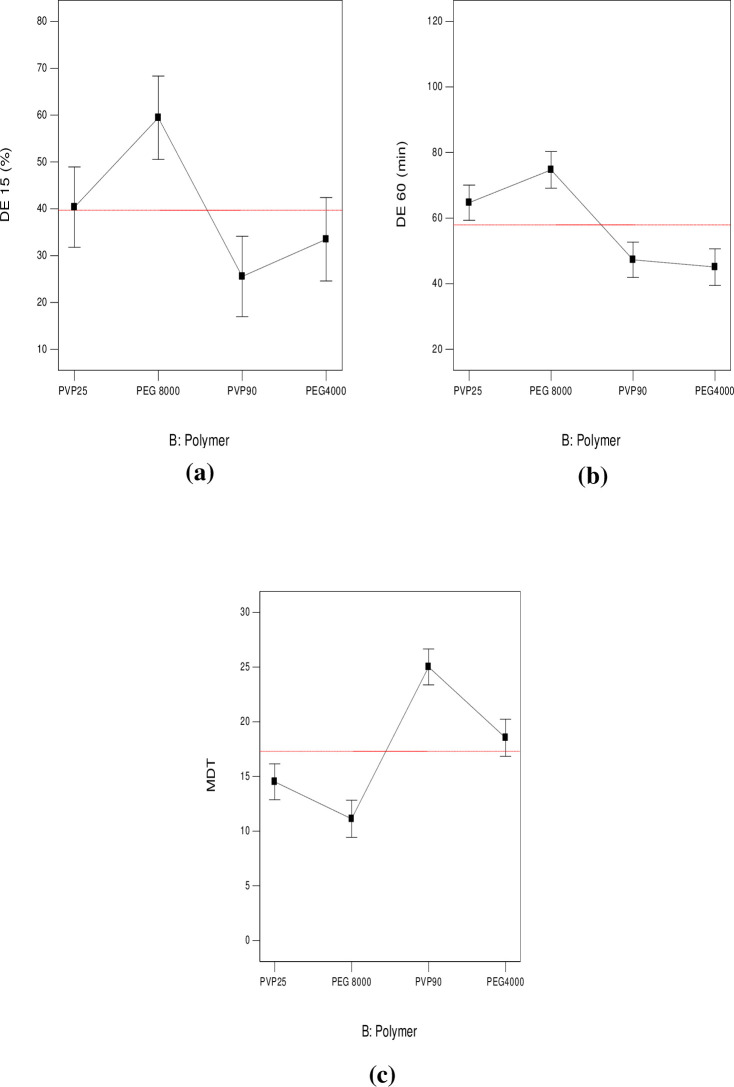
Line plots for the effect of polymer type on DE (15 min) % (a), DE (60 min) % (b) and MDT (c).